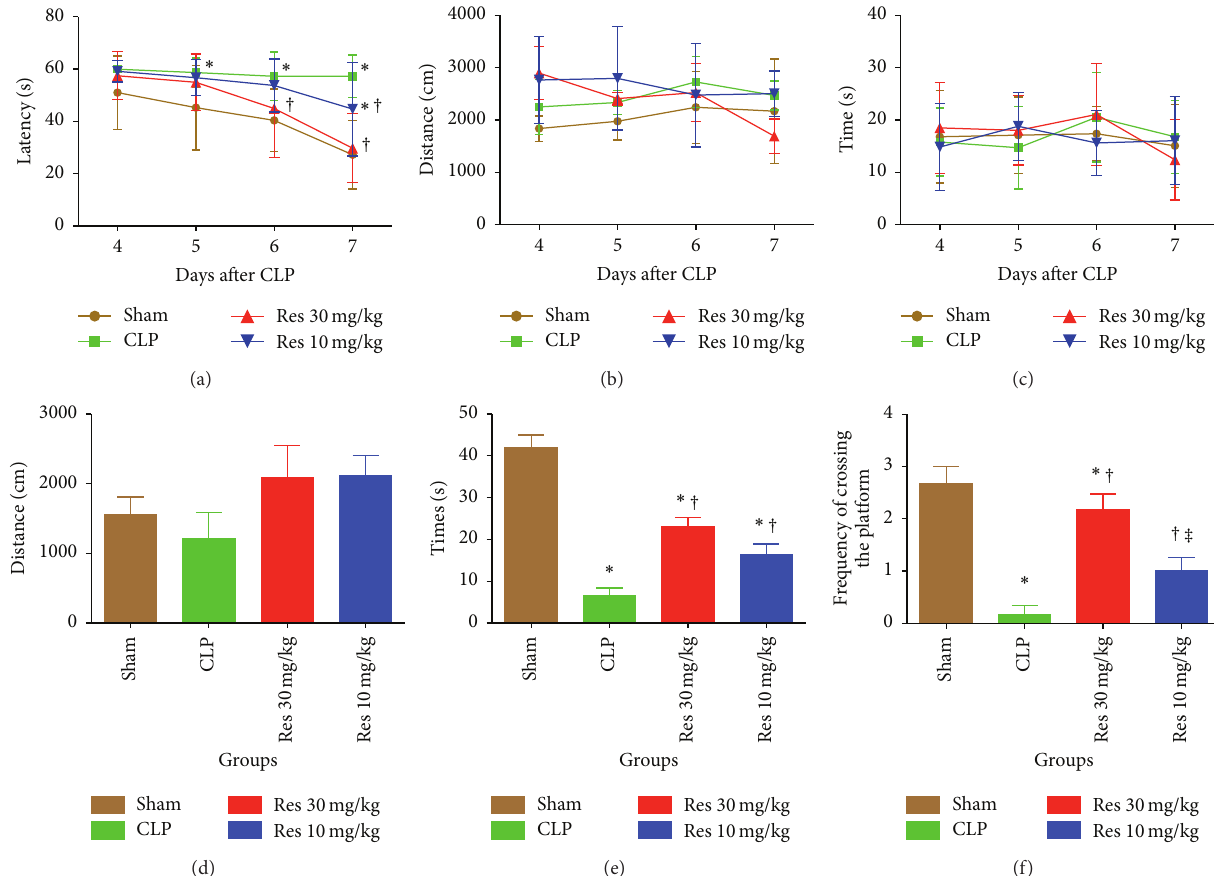
Figure 1: Morris water maze training (a)–(c) and hidden platform tests (d)–(f). (a) Latency to escape; (b) total distance of swimming; (c) time spent in the target quadrant; (d) distance of swimming; (e) times spent in the target quadrant; (f) frequencies of platform crossing. Res1 was treated with a higher dose of resveratrol (30 mg/kg), while Res2 was treated with a lower dose of resveratrol (10mg/kg). ∗ 𝑃 < 0.05 compared with Sham group, † 𝑃 < 0.05 compared with CLP group, ‡ 𝑃 < 0.05 compared with Res1 group, by two-way ANOVA test (a)–(c) or one-way ANOVA and LSD test (d)–(f). Bars represent the mean ±